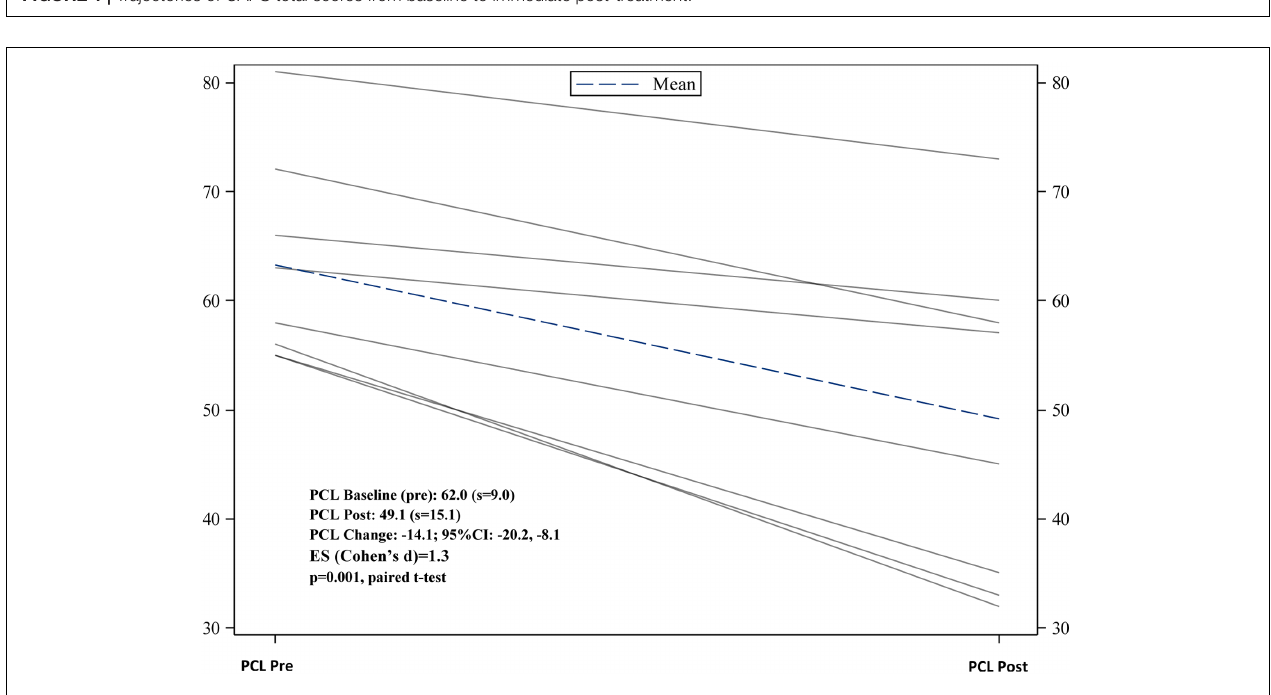
FIGURE 1 | Trajectories of CAPS total scores from baseline to immediate post-treatment.